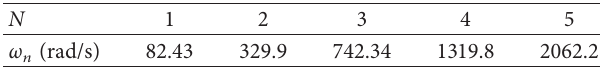
Table 1: First five order natural frequencies of the beam in the